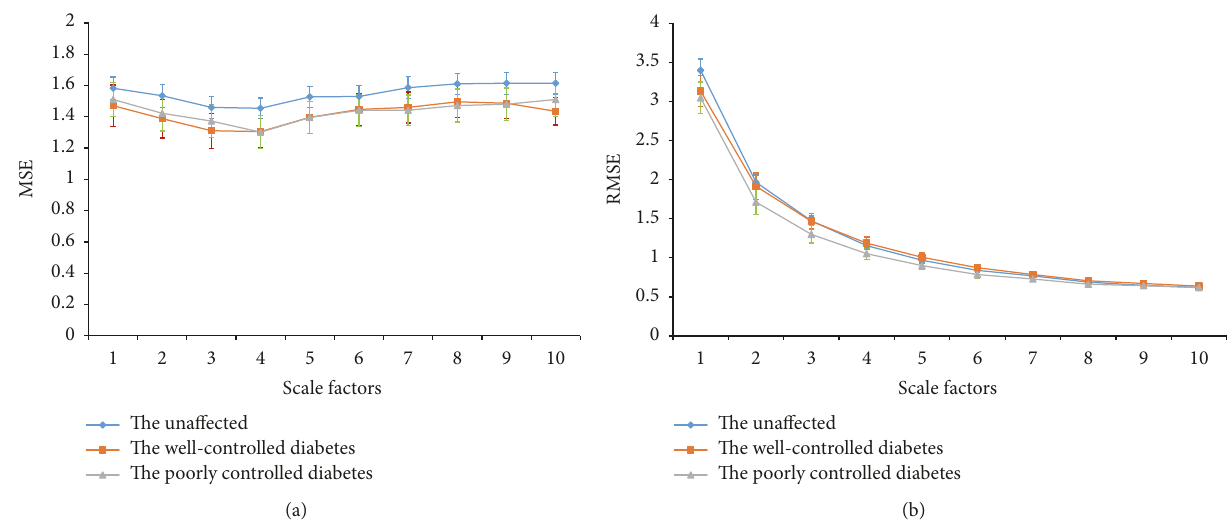
Figure 3: The MSE and RMSE index of ECG R-R intervals with the standard error (vertical bar) of the unaffected (solid blue line), the well-controlled diabetes (solid orange line), and the poorly controlled diabetes (solid grey line) groups at each scale